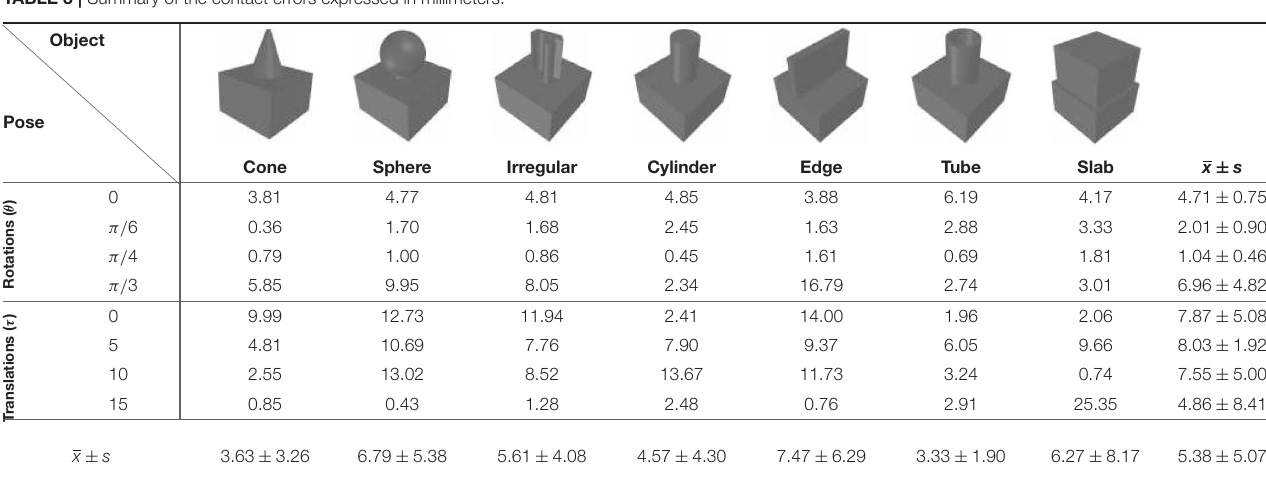
TABLE 3 | Summary of the contact errors expressed in millimeters.